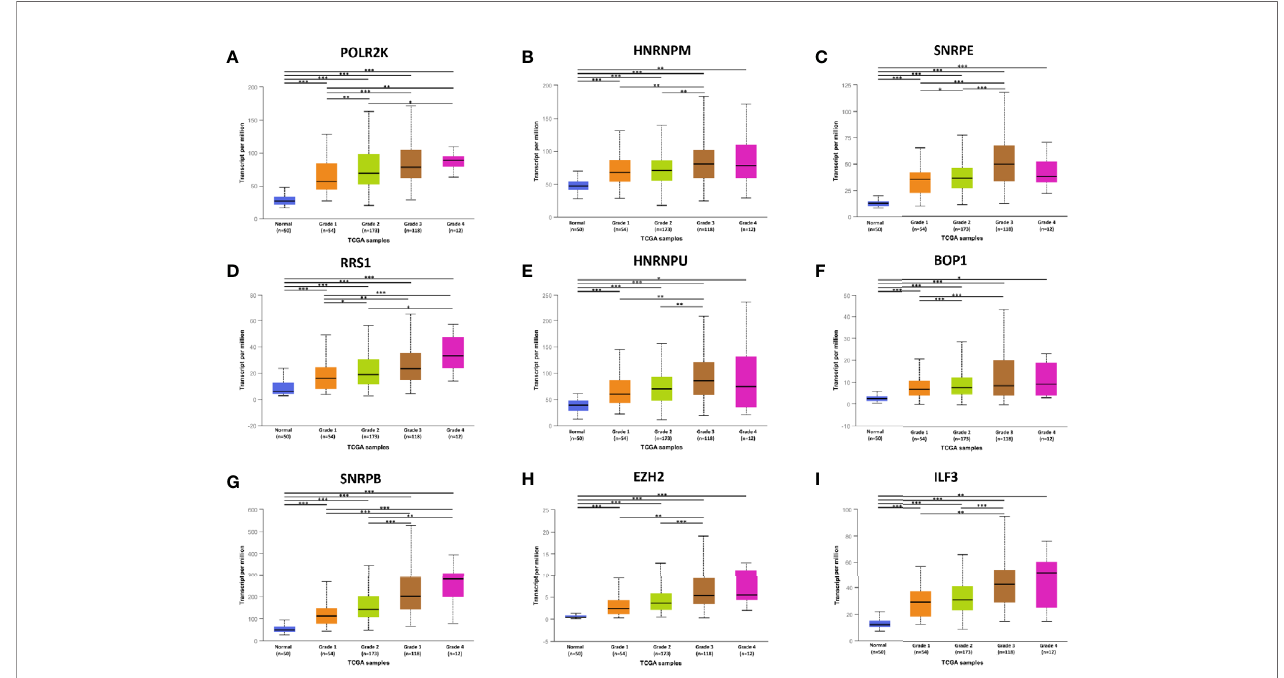
FIGURE 4 | The relationship between hub genes expression and tumor grades in HCC. *P < 0.05, **P < 0.01, ***P <